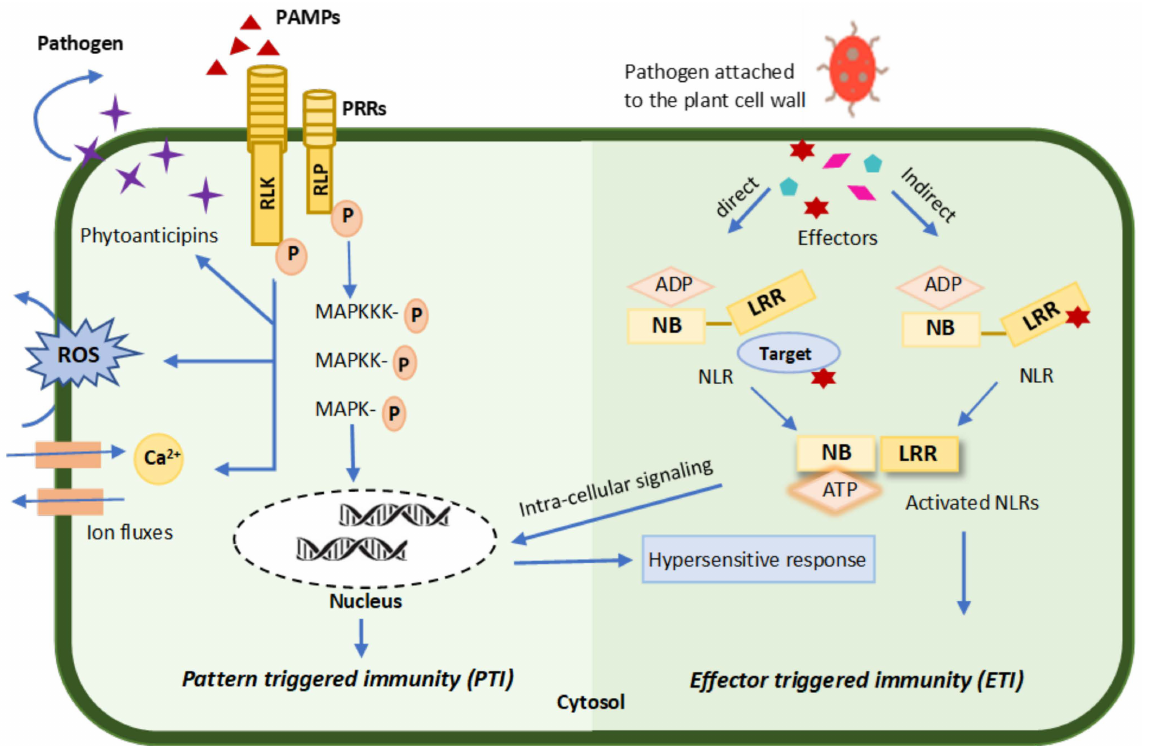
Figure 5. Schematic representation of plant immunity against phytopathogens through pattern- triggered immunity (PTI) and effector-triggered immunity (ETI). PTI is activated through the recogni- tion of pathogen-associated molecular patterns (PAMPs) by the pattern recognition receptors (PRRs) in plant cell walls. After PAMP recognition, the plant triggers a signal cascade that further induces multiple intracellular defense responses and activates defense genes. In response to PTI, pathogens secrete effectors that are recognized by nucleotide-binding (NB) and leucine-rich repeat (LRR) recep- tors (NLRs) and develop another defense layer called ETI. Activated NLRs with many intracellular signaling events trigger the hypersensitive response